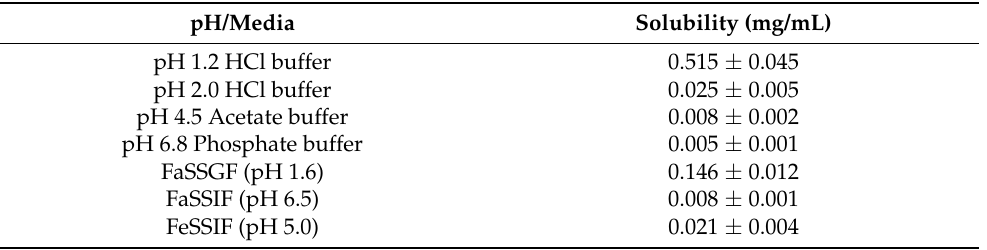
Table 2. Measured solubility pro fi le of pure ABZ in various pH systems and biorelevant media at 37 ± 2.0 °C.